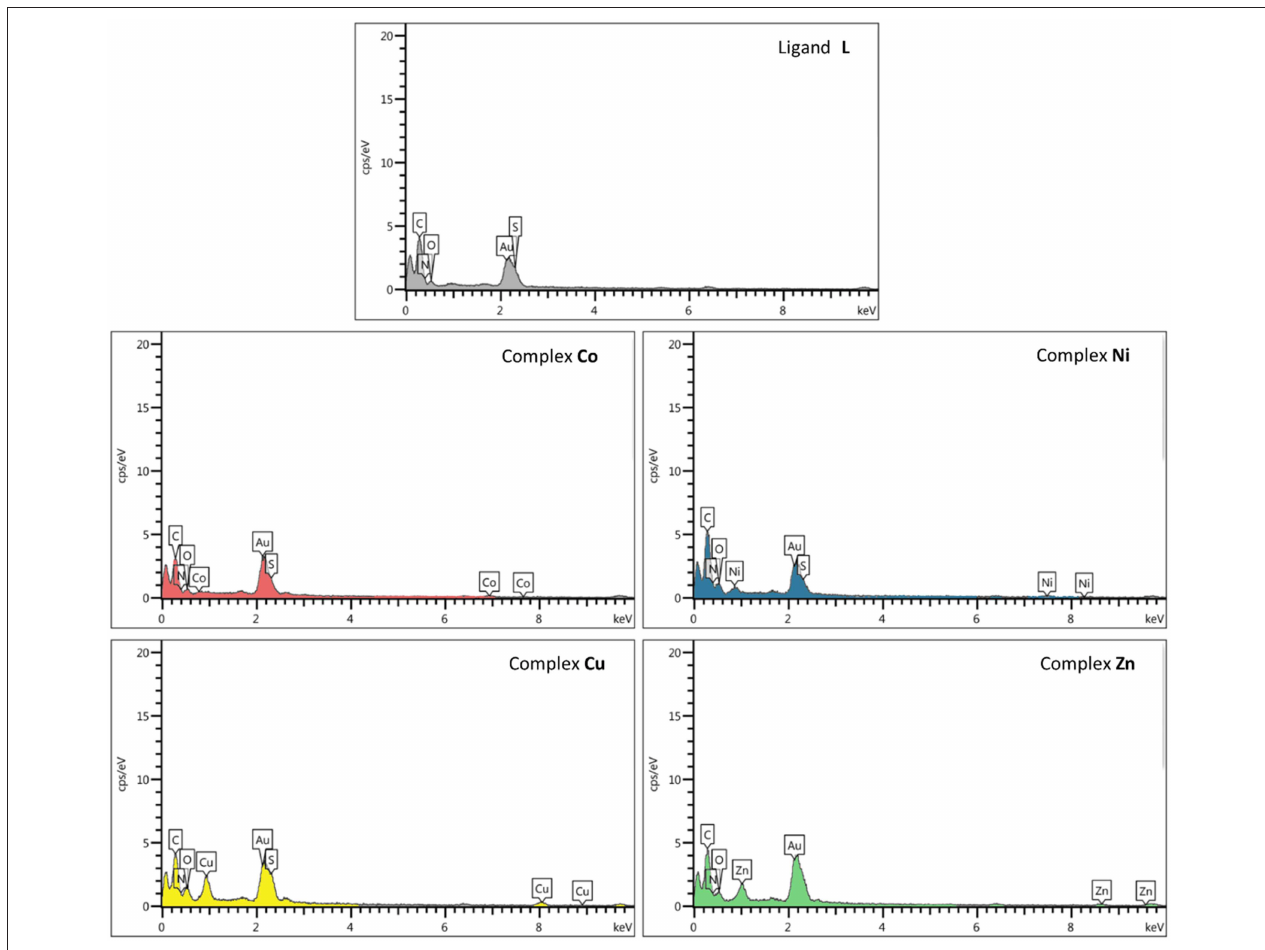
TABLE 2 | Antibacterial activity of synthesized compounds against different microorganisms in with the microbroth dilution method. Microorganisms Gram positive Gram negative Staphylococcus aureus Bacillus subtilis Escherichia coli Pseudomonas aeruginosa MIC